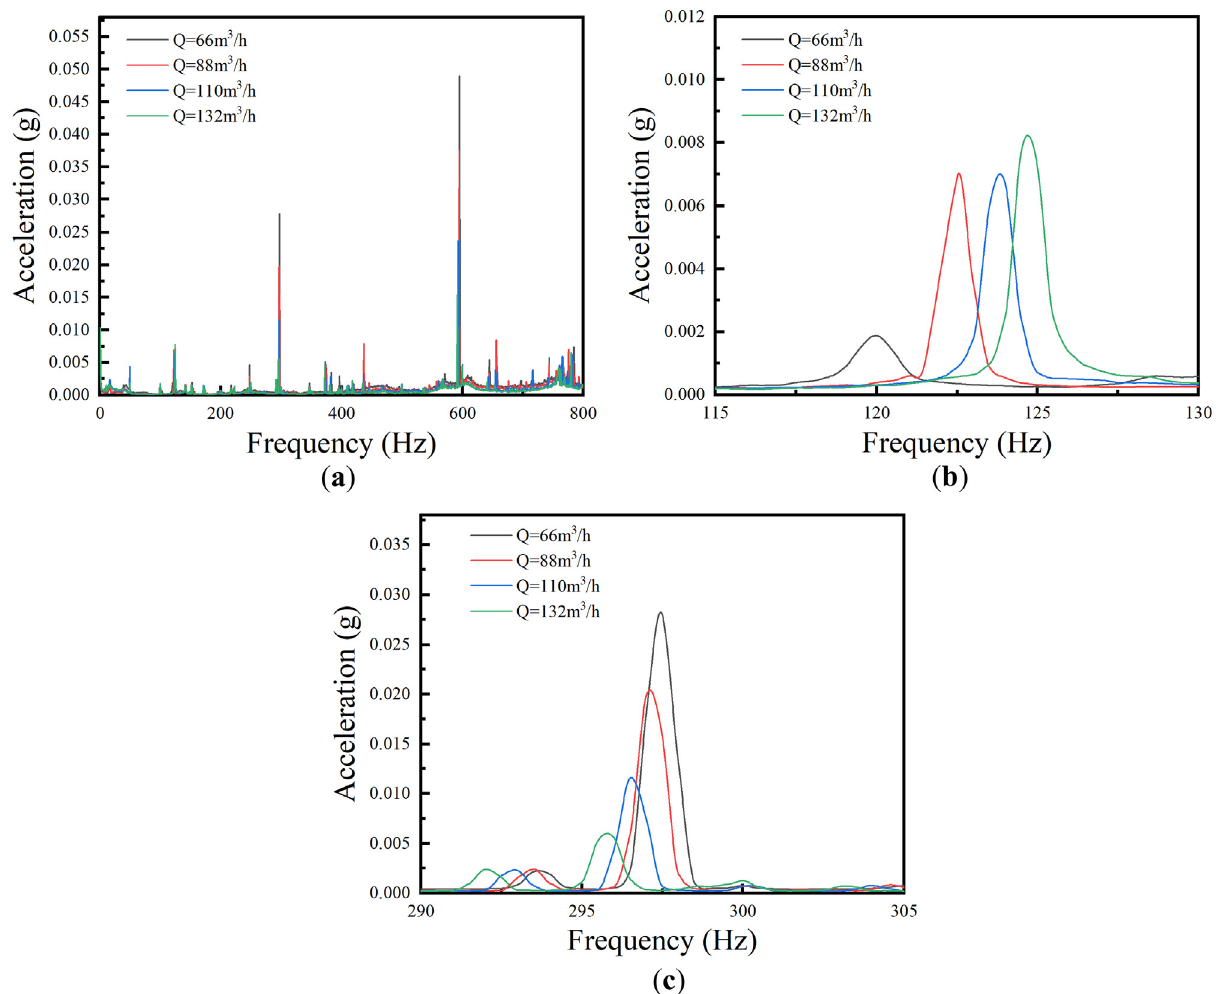
Fig. 1. Vibration response spectrum of pump casing at different fl ow rates. (a) 0 – 800Hz; (b) 115 – 130 Hz; (c) 290 – 305 Hz.